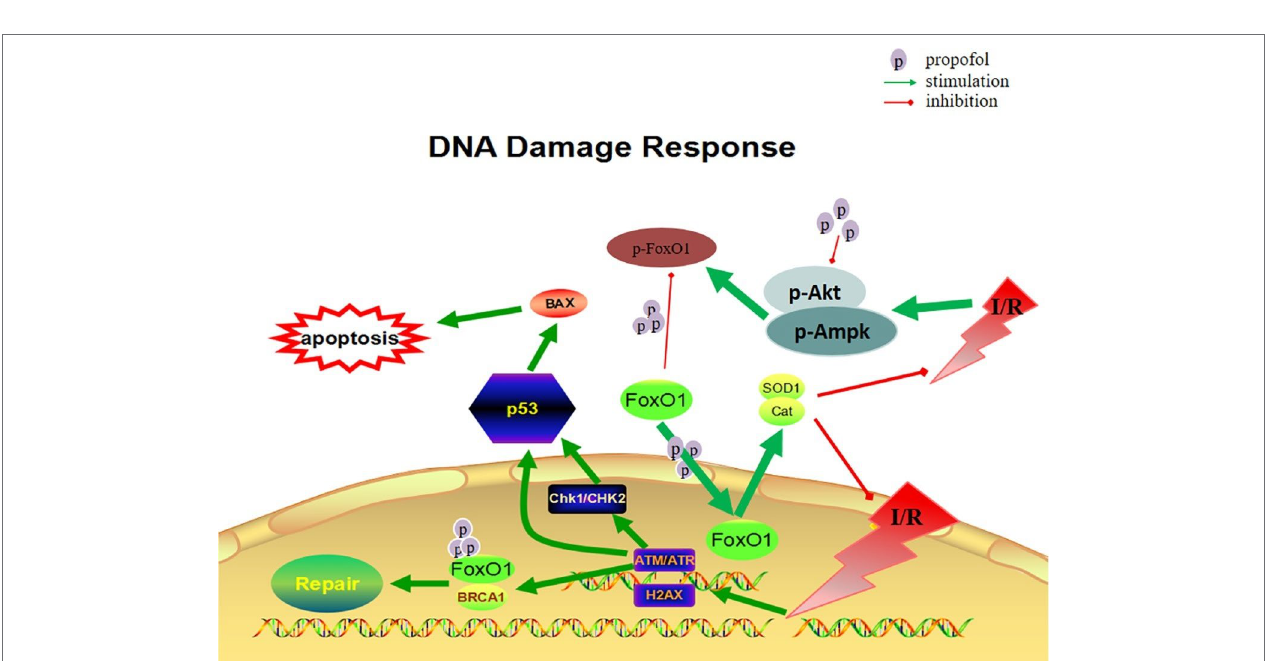
FIGURE 7 | Diagram of DNA damage response via FoxO1